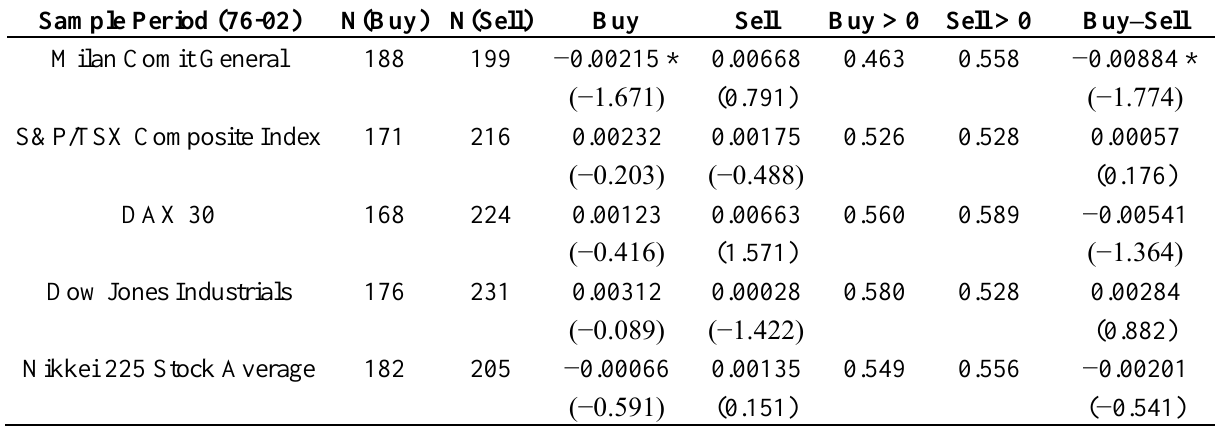
Table 3A. Average ten-day returns from RSI (7,